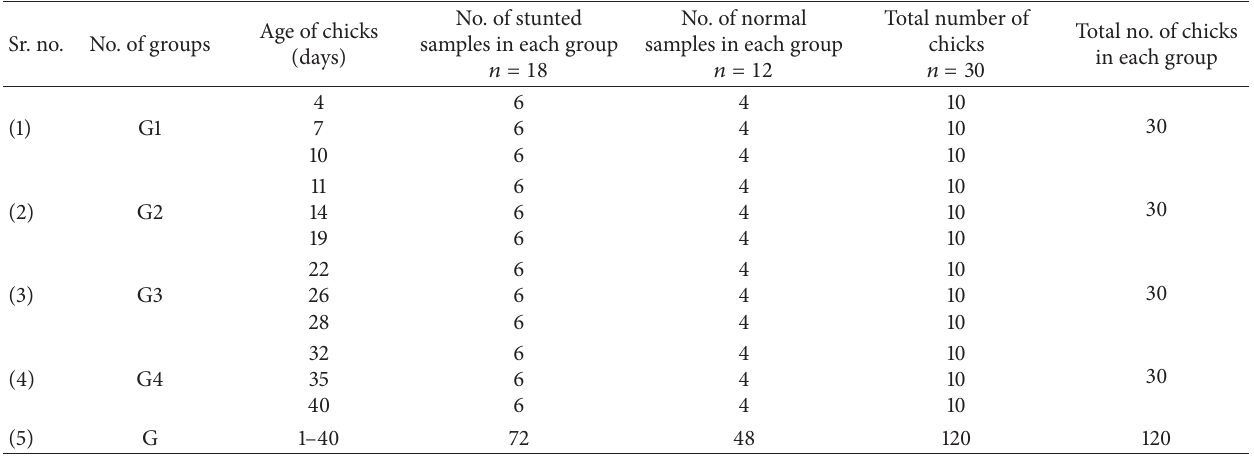
Table 1: Grouping of experimental chicks.